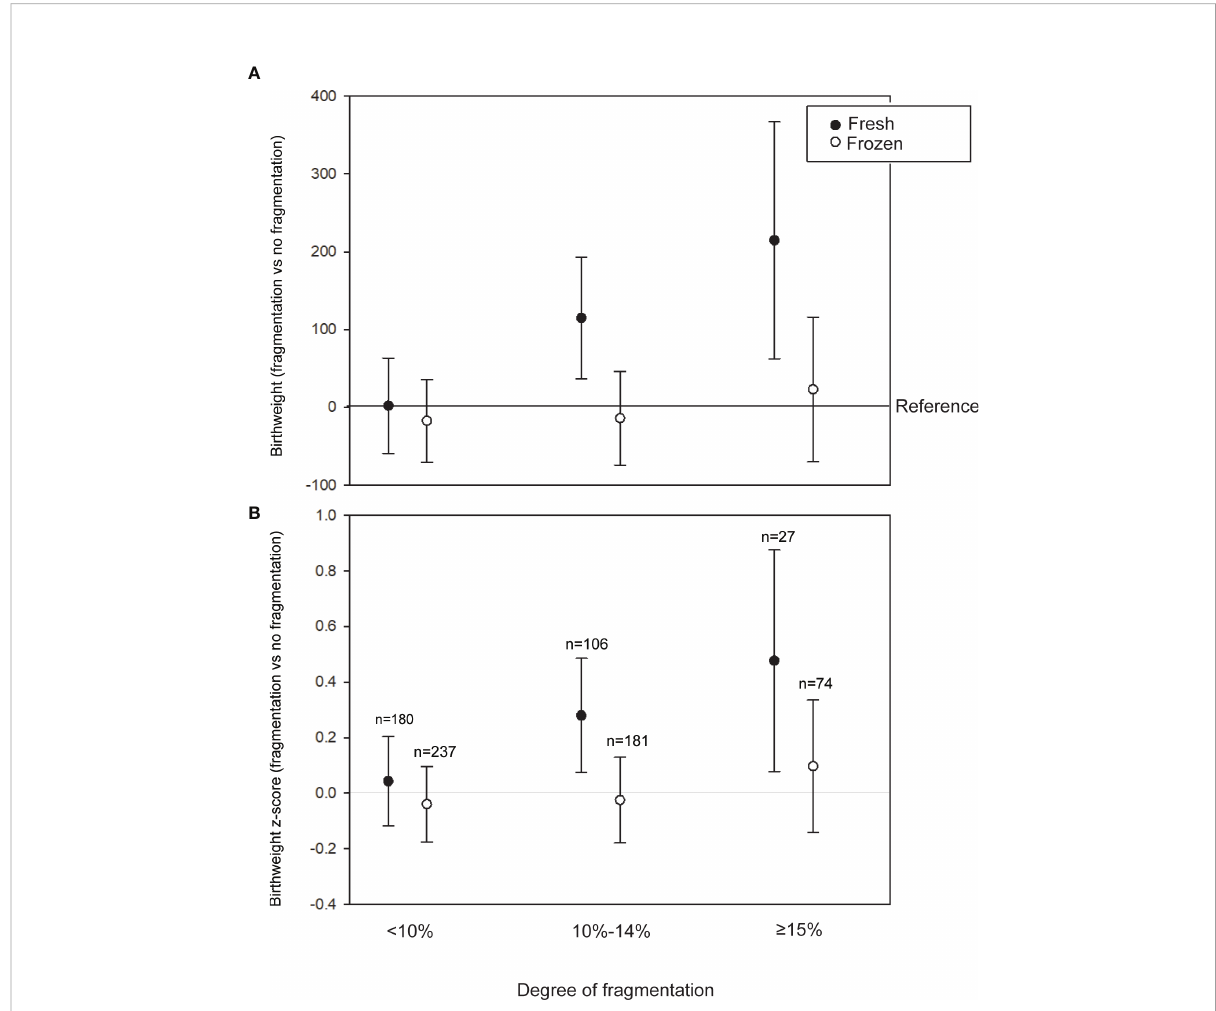
FIGURE 1 Association between the degree of fragmentation and birth weight in the fresh (cleavage and blastocyst transfer) and frozen-thawed cycles. (A) Adjusted regression coef fi cients of fragmentation degrees for birth weight using no fragmentation as a reference. (B) Adjusted regression coef fi cients of fragmentation degrees for birth weight z-score using no fragmentation as a reference. Models are adjusted for maternal age, body mass index (BMI), parity, peak estradiol level, endometrial thickness, insemination protocol in vitro fertilization (IVF) or intracytoplasmatic sperm injection (ICSI), female etiologies (tubal factor, endometriosis), order of transfer (1 or >1), mode of delivery (virginal or Cesarean), and year of